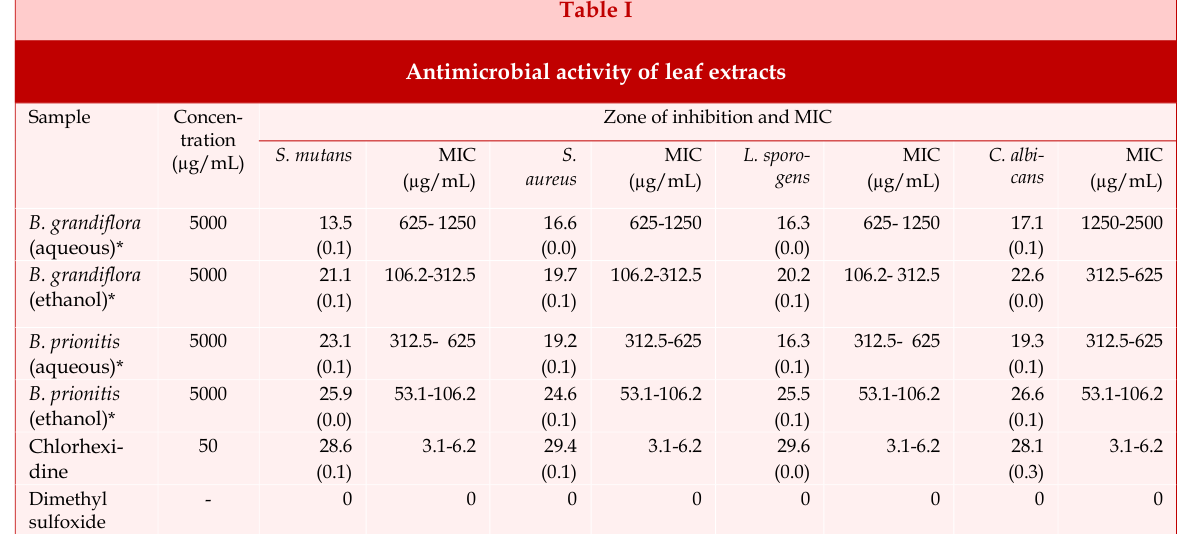
microbes followed by the extract of B. grandiflora . B.